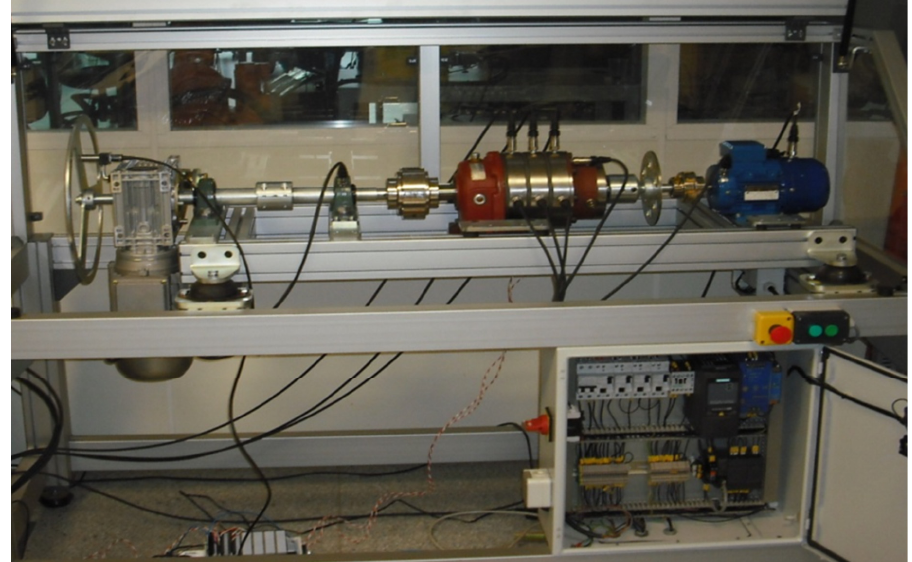
Figure 4. Wind turbine